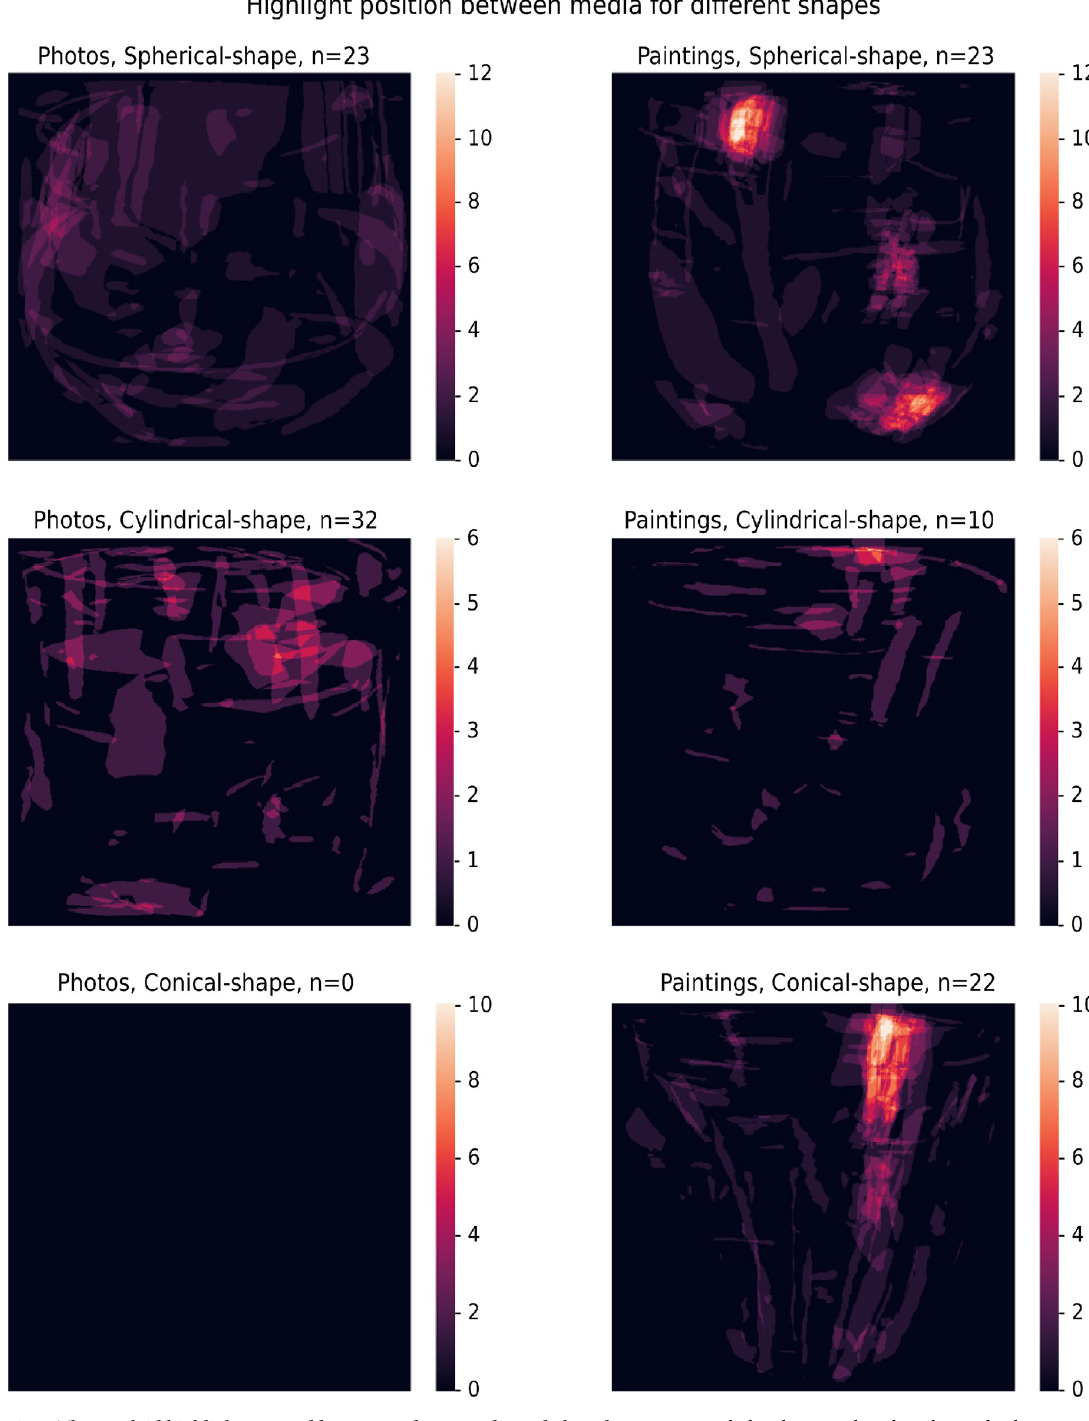
Fig 4. The overlaid highlights created by users, split on media and glass shape. In general, the photographic glass shapes display more variability and do not display a clear pattern. Note that for photos, no stimuli existed with a conical shape in our set which leads to a black image, since there were no highlight-annotations. On the right, for painted glasses, we see clear patterns in the placement of highlights for each glass shape.